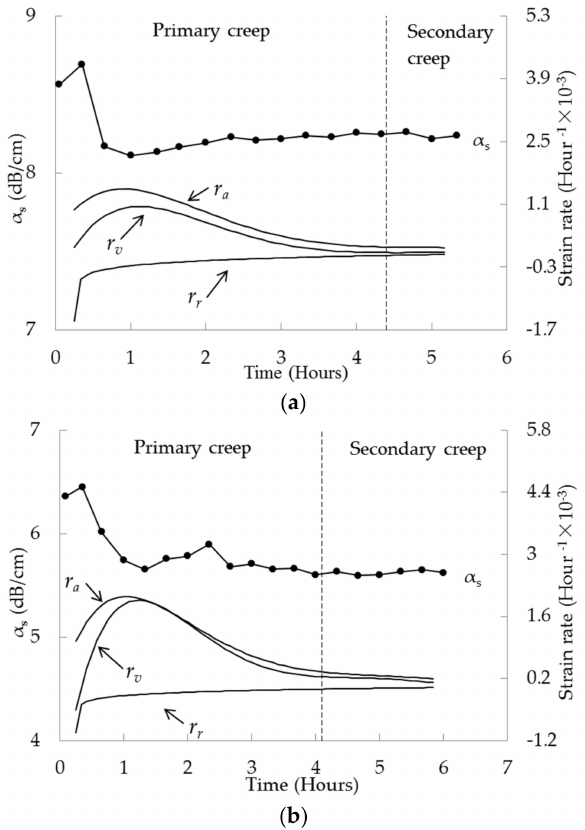
Figure 14. Graphs showing the spatial attenuation parameters and strain rates plotted versus time for Type 2 creep. Results are shown for tests at: ( a ) 10.00 MPa; ( b ) 17.01 MPa. r a , r v , r r , and α s denote axial strain rate, volumetric strain rate, radial strain rate, and spatial attenuation parameter, respectively. The dashlines denote the transition points of creep